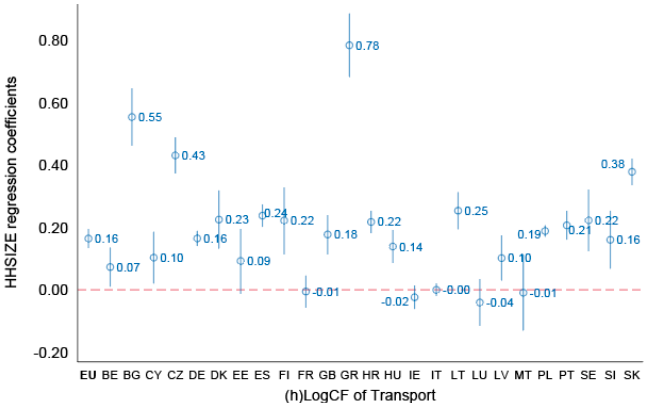
Figure 7. Regression coefficients for household size effects on the logarithm of the per capita annual carbon footprint by consumption category. Categories: ( a ) Actual and imputed rent; ( b ) Electricity; ( c ) Household services, e.g., waste treatment, water supply, insurance; ( d ) Food; ( e ) Gas, liquid and solid fuels; ( f ) Other services and manufactured products; ( g ) Appliances, equipment and furniture; and ( h ) Transport. The categories are ordered by the median HHSIZE effect depicting the importance of the household economies of scale from the strongest to the weakest. Household weights provided by the HBS have been applied.